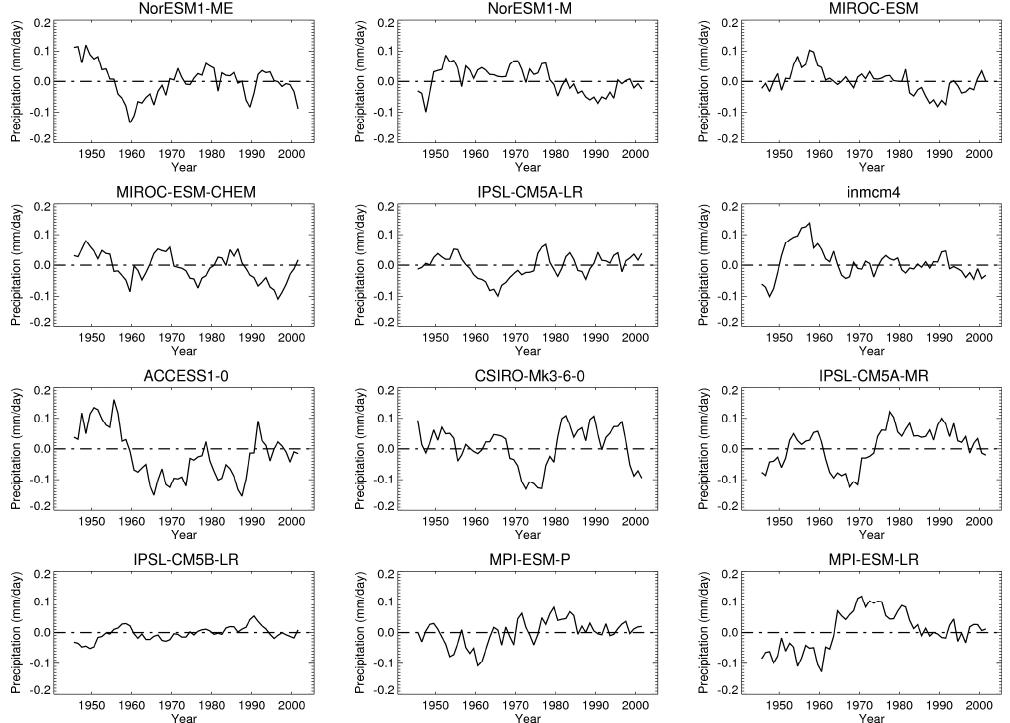
Figure 3. The eleven-year running mean of ISM precipitation (historical run for various CMIP5 model outputs) time series in the CI region is presented for the last fifty years. The anomaly is calculated relative to an average of the period (1940–2005).